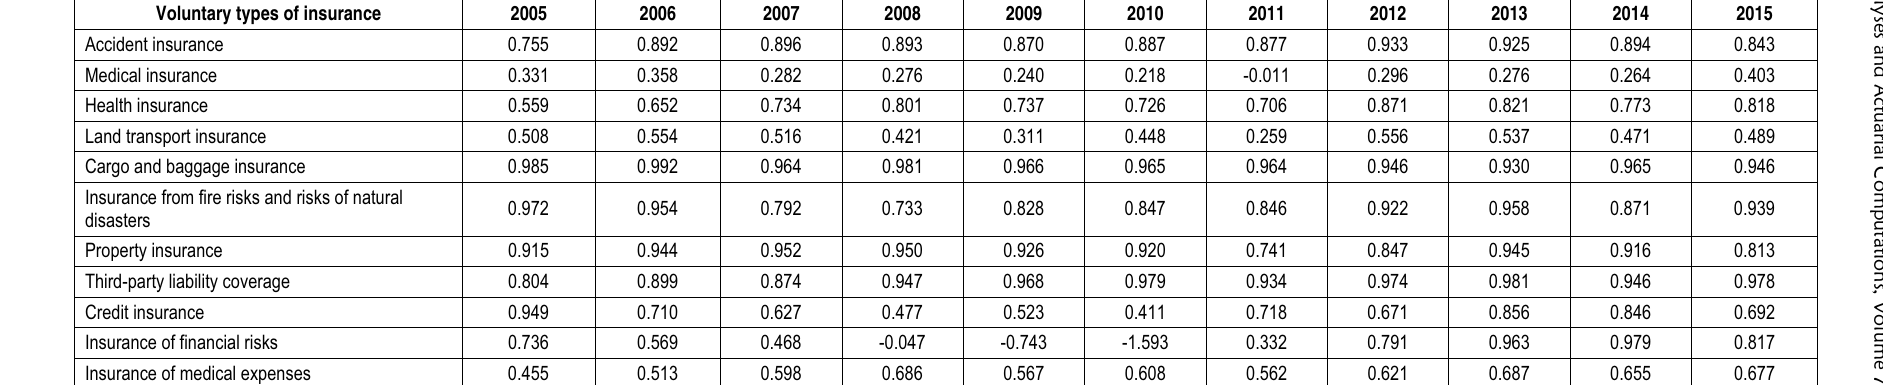
Table 3. Indicators of profitability of the voluntary types of insurance in 2005-2015, thousand